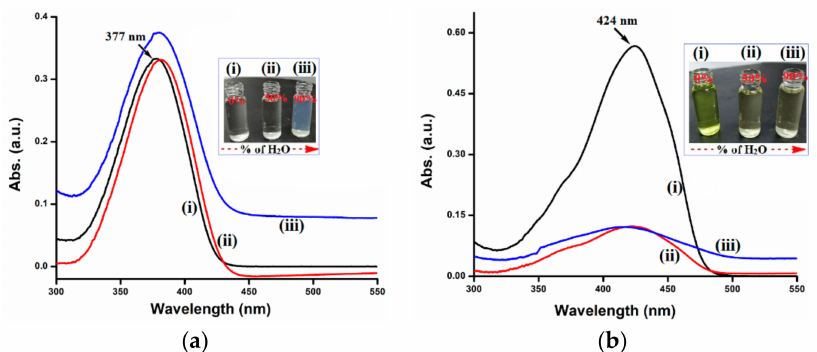
Figure 3. UV-Vis spectra of ( a ) AIE-1 (20 µ M) and ( b ) AIE-2 (20 µ M) in THF with (i) 0%, (ii) 50%, and (iii) 90% water. Inset figures show the color changes with di ff erent water